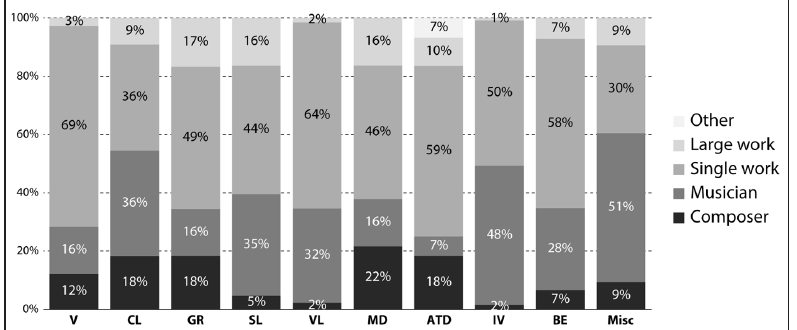
Figure 6: Type of reference (relative) per